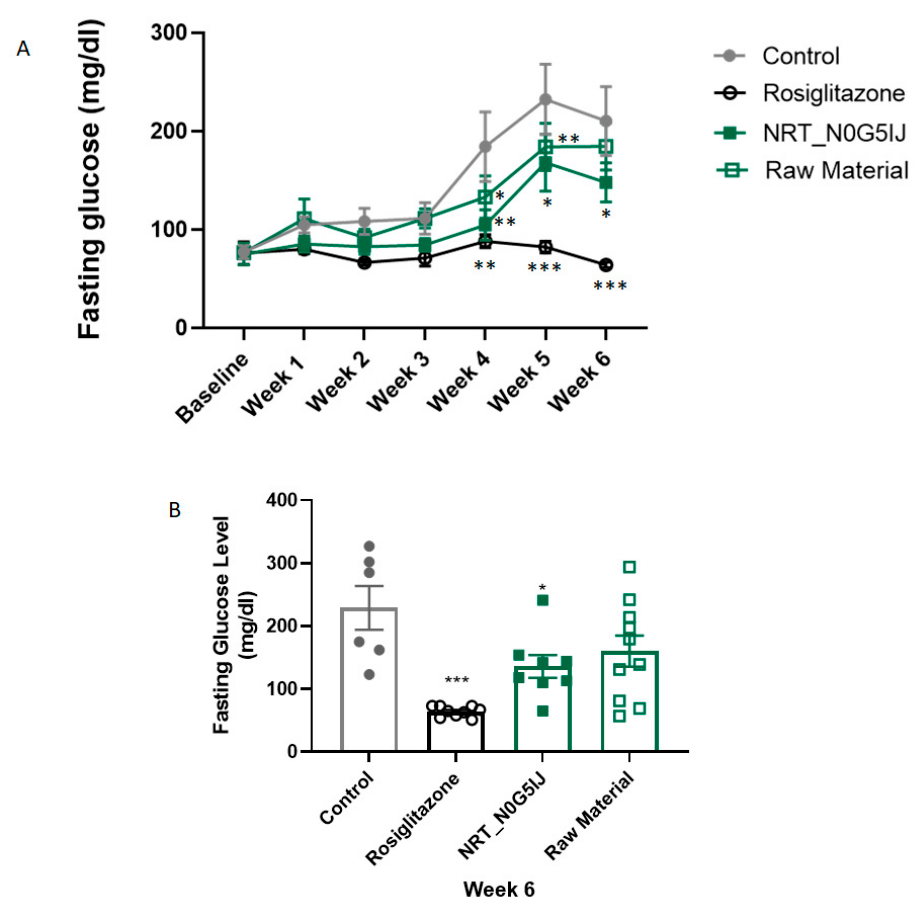
Figure 3. NRT_N0G5IJ significantly increases the ability to regulate blood glucose levels in db/db mice. Mice were treated with NRT_N0G5IJ (400 mg/kg/day), raw material (400 mg/kg/day), rosiglitazone (15 mg/kg/day), or vehicle by oral gavage. ( A ) Fasting blood glucose concentrations were determined weekly for 6 weeks. Two-way ANOVA analysis with Dunnett’s post hoc test. ( B )) One-way ANOVA analysis of fasting blood glucose levels at week 6. Data are the mean ± SEM of n = 9 per group (* p < 0.05, ** p < 0.01; *** p < 0.001).